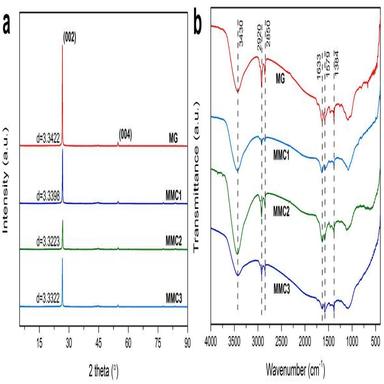
The raw microcrystalline graphite (MG) and designed MMC support materials: (a) XRD patterns; (b) FTIR spectra.